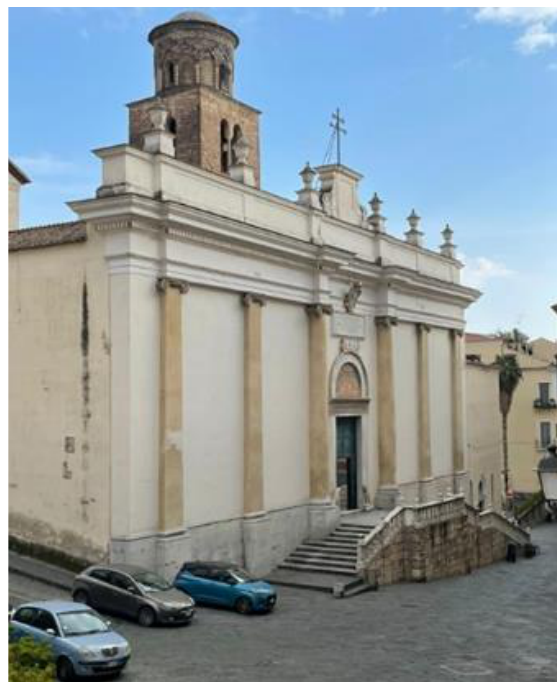
Figure 1. The current aspect of the facade of the Cathedral of San Matteo in Salerno (Italy).